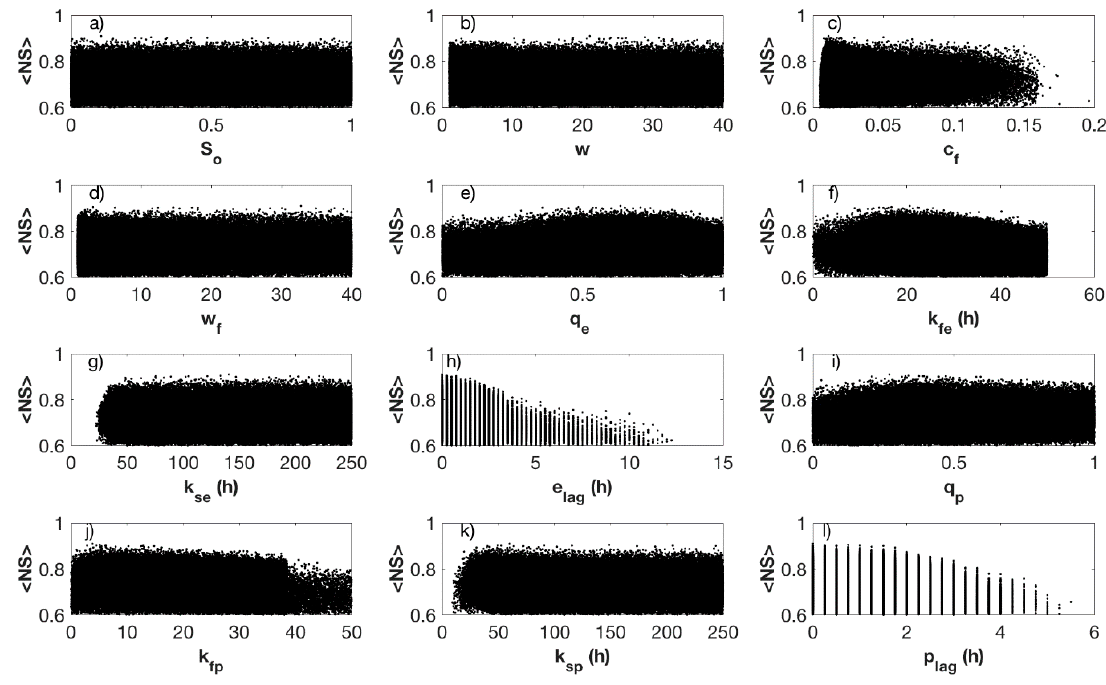
Figure 6. Dotty plots of the Monte Carlo simulations for the calibrated parameters using TraSPAN model structure 4 using electrical conductivity (EC). Parameter names are shown in Table 1.